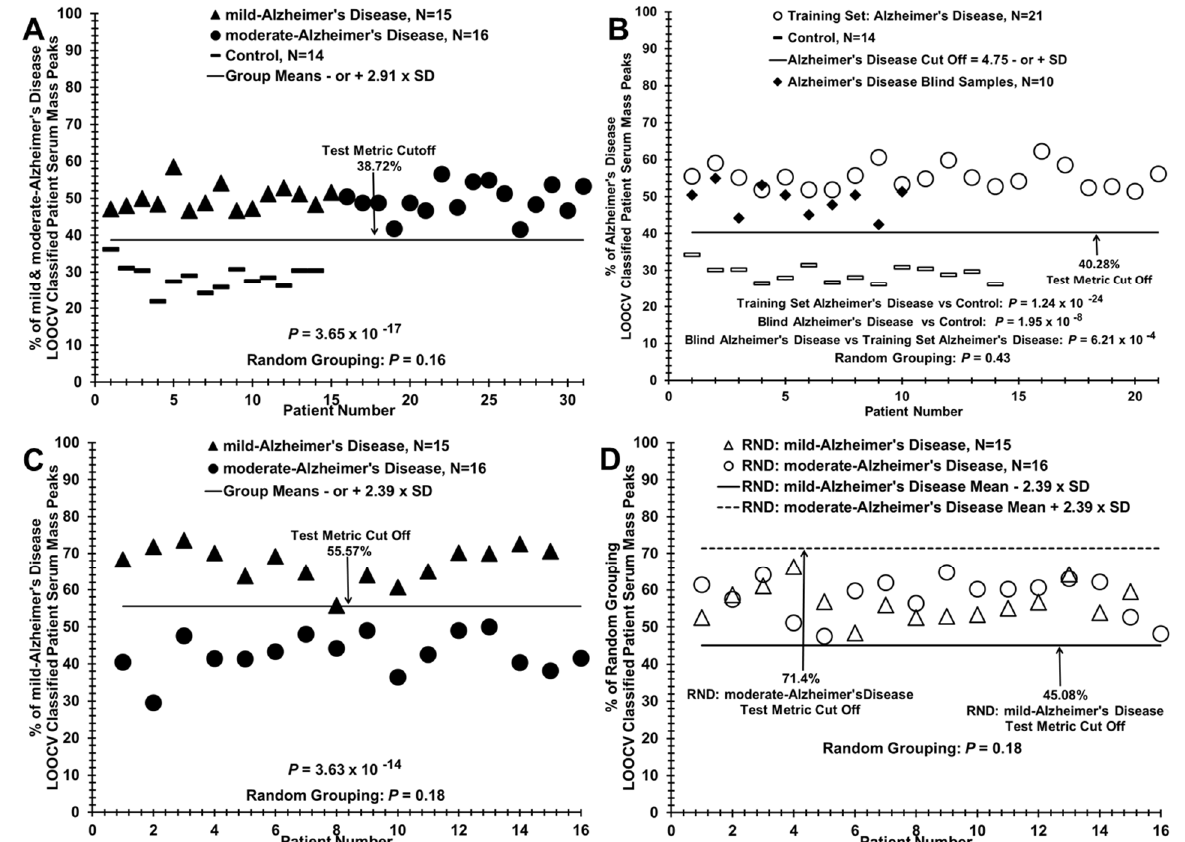
Figure 3. Assigning pathology grouping to a blinded set of AD patient sera vs. controls and discriminating sera of mild AD patients from moderate AD patients. ( A ) Distinguishing mild and moderate AD patient sera as a group ( N = 31, dark triangles and circles) versus controls ( N = 14, dashes) for formation of the training set used in panel B. ( B ) Assigning correct group pathology to a blinded “left out” group of AD patients ( N = 10, dark diamonds) from panel A against a training set of AD patients, N = 21 (open circles) and controls N = 14 (dashes) from panel A. ( C ) Distinguishing mild AD patient sera (dark triangles) from moderate AD patient sera (dark circles) using the LOOCV/PCV procedure. ( D ) Randomization of the two groups in panel C showing